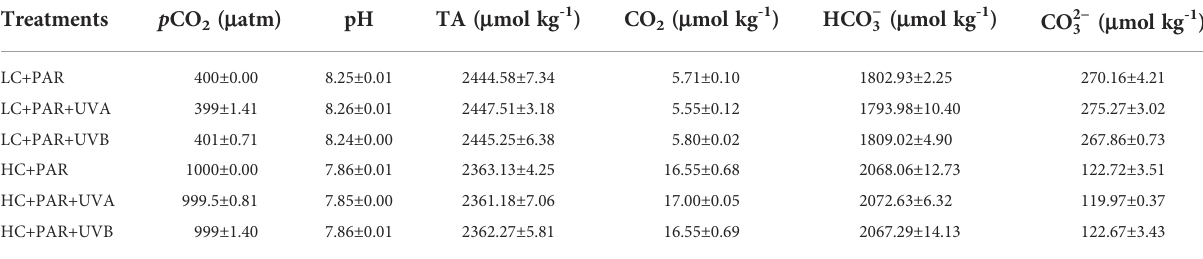
TABLE 2 Seawater carbonate system parameters under ambient CO 2 (LC: 400 uatm) and elevated CO 2 (HC: 1000 ppm), treated with different radiation treatments (PAR; PAR+UVA; PAR+UVB).